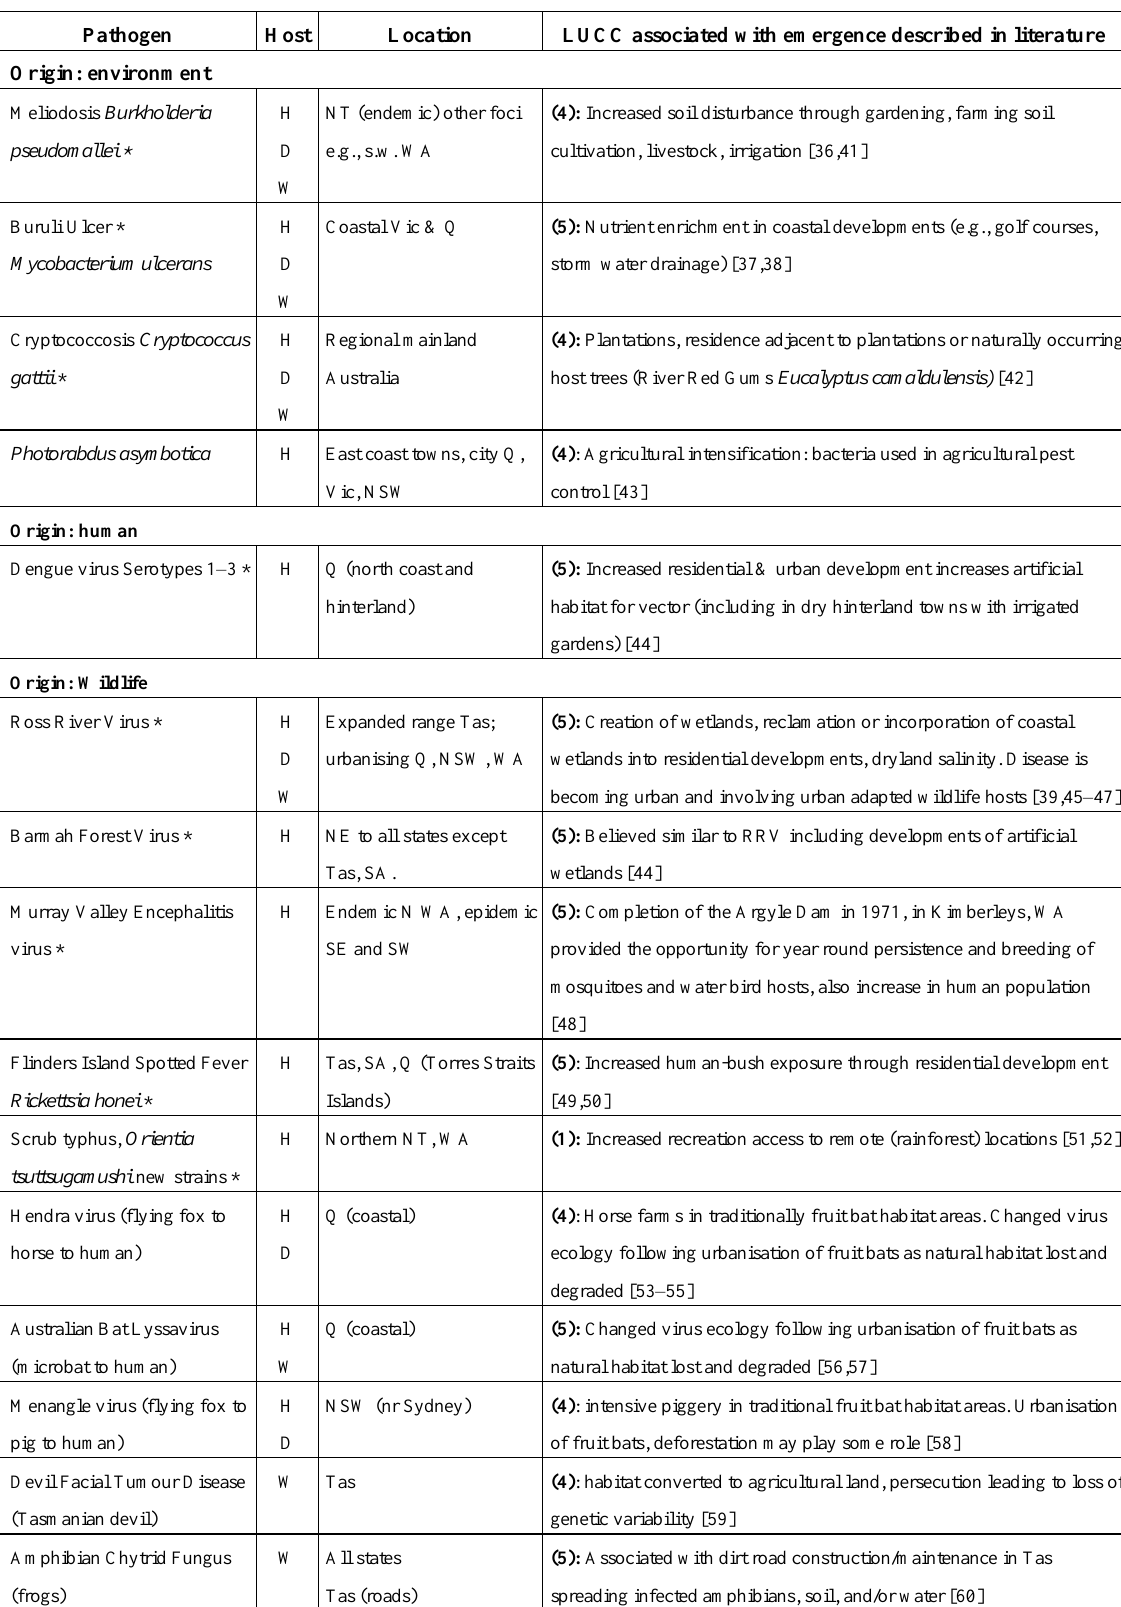
Table 1. Emerging Infectious Diseases (EID) of Australian humans and animals with associations with land use change (LUCC) (n = 20) based on a systematic review of literature 1973–December